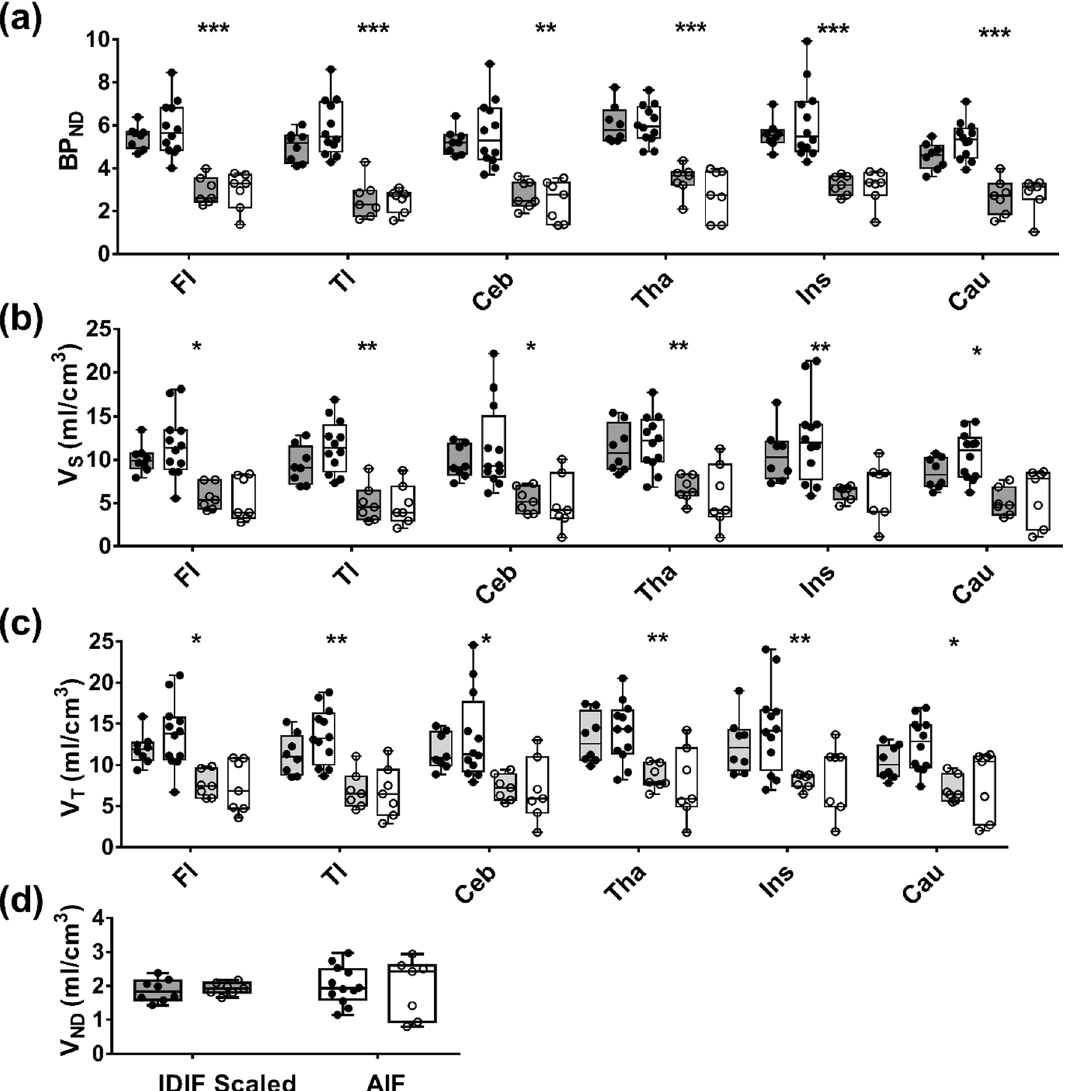
Fig. 5 Results from applying SIME to data from healthy controls in which the AIF was measured directly (clear box plots) and those with venous metabolite-corrected IDIFs (gray box plots): a regional BP ND , b regional V S , c regional V T and d common V ND . Data are presented as box–whisker plots with the median indicated by a black line. In all cases, data were divided into HABs (filled circles) and MABs (open circles). Significant between HABs and MABs are indicated by asterisk (* p < 0.05, ** p < 0.01 and *** p <